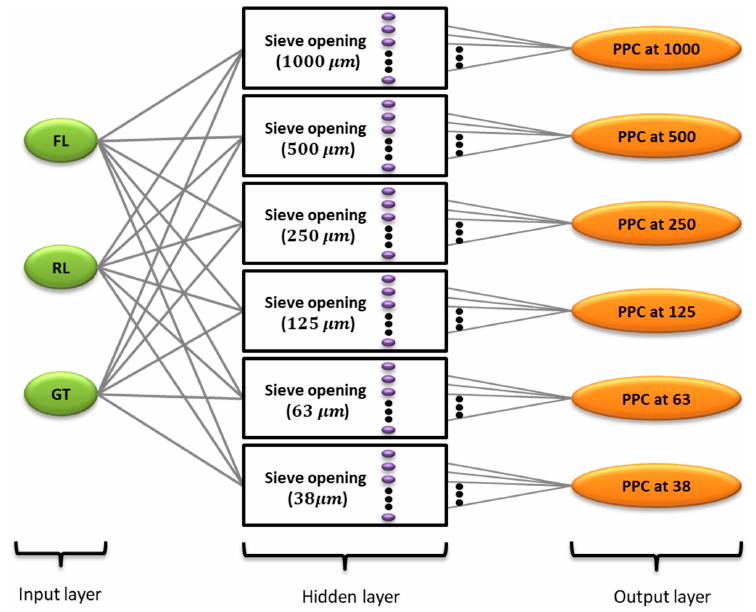
Figure 1. Schematic of the proposed ANN models for PPC predictions. (FL—Feed Load (Vol.%), RL—Rod Load (Vol.%), GT—Grinding Time (min.), SO—Sieve Opening ( μm ), and PPC—Percentage of Passing Cumulative (%)).